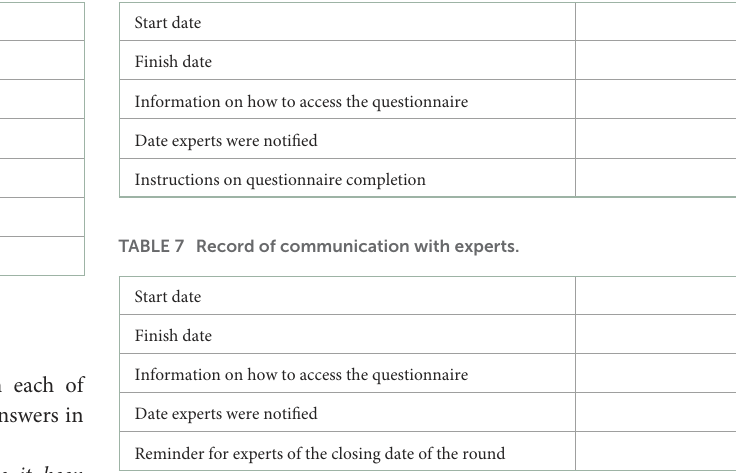
Table 6) to the experts: start date, finish date, how to access the questionnaire, the date on which the panel will be contacted, and instructions about how to answer the questionnaire.